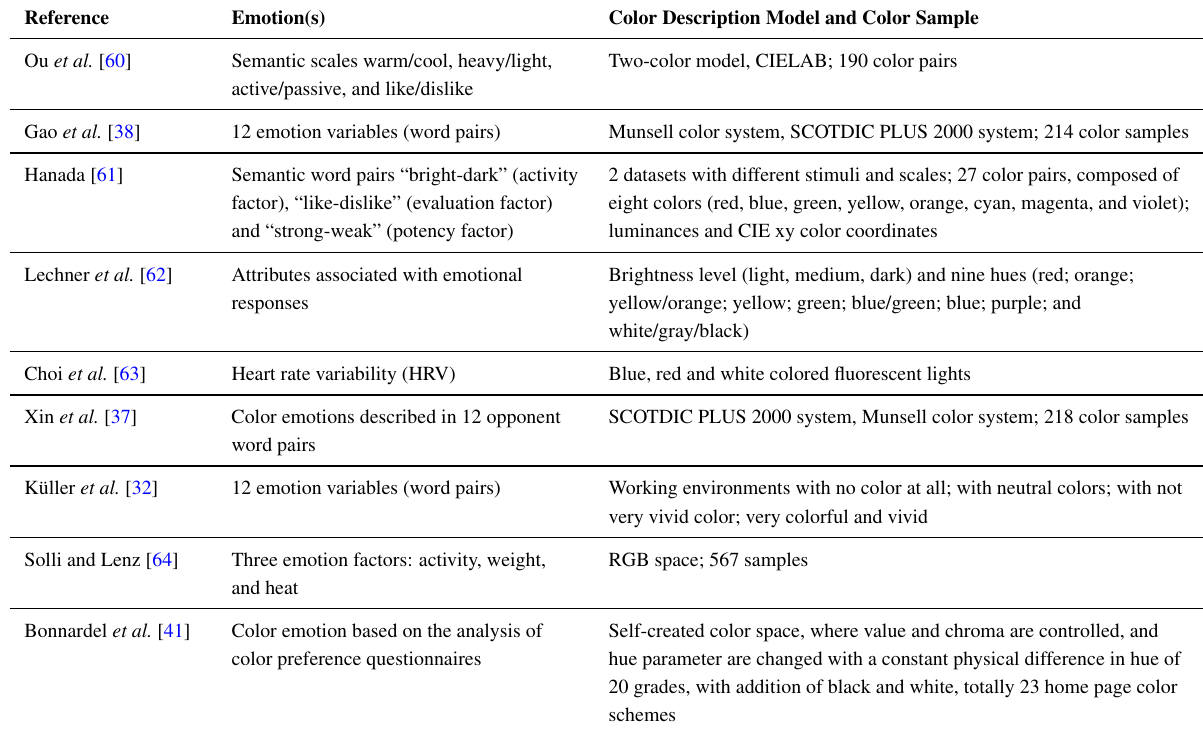
Table 1. Color in visual affect